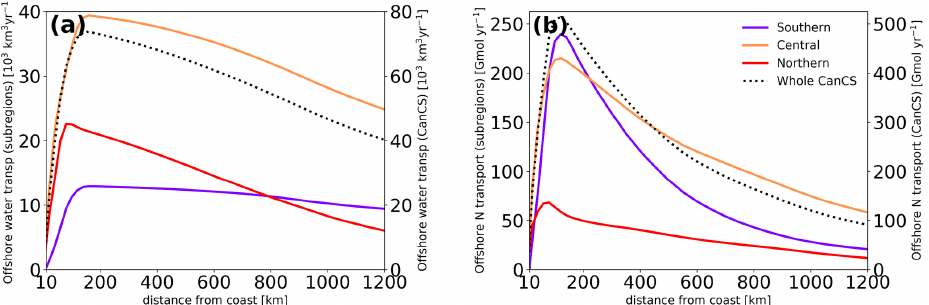
Figure 4. Net offshore transport of (a) water and (b) nitrogen as a function of the distance to the coast in the three subregions (left axis) as well as the entire CanCS (right axis) in our experiment.